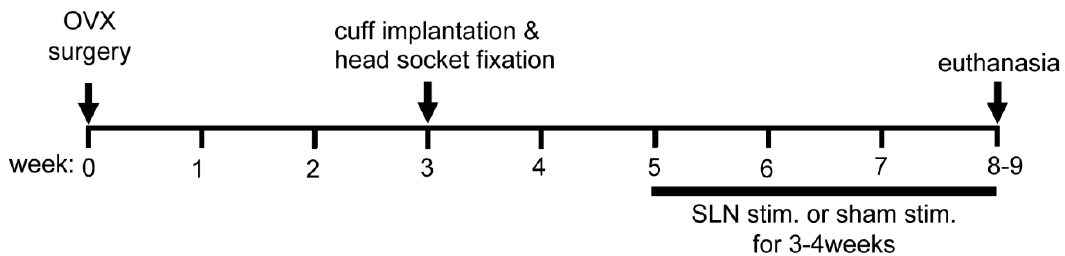
Figure 1. Time schedule of Experiment 2. Rats received ovariectomy (OVX) surgery at 12 weeks of